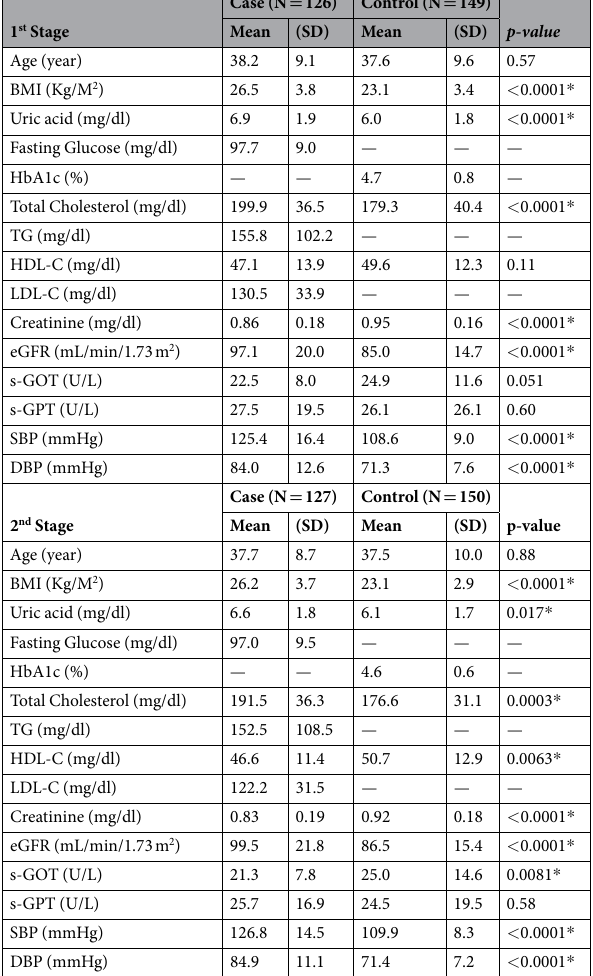
Table 1. Characteristics of the participants – continuous traits. BMI: body mass index, TG: triglyceride, HDL- C: high density lipoprotein cholesterol, LDL-C: low density lipoprotein cholesterol, SBP: systolic blood